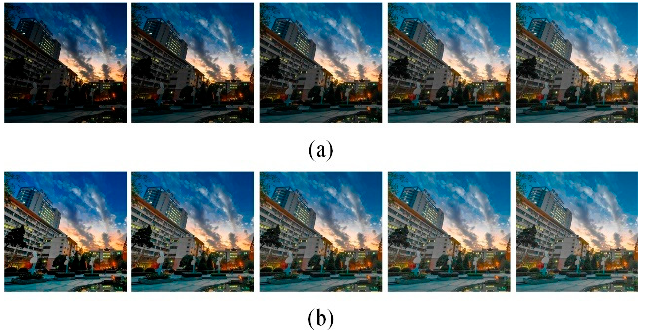
Figure 12. Park. ( a ) Input different global illumination image sequences. ( b ) Output almost the same global illumination image sequence.